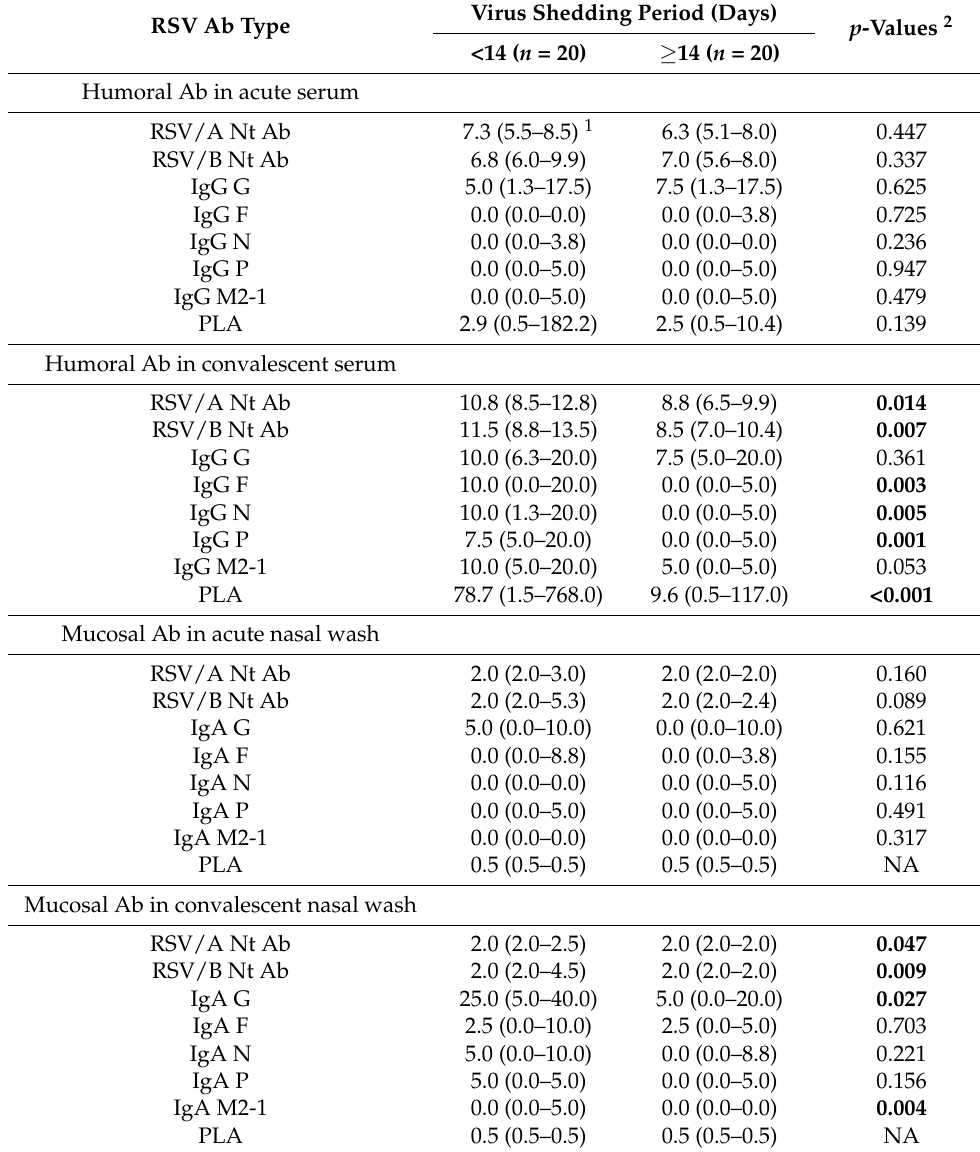
Table 2. Comparison of Humoral and Mucosal RSV Antibody Level between RSV-Infected HCT Recipients Who Shed RSV < or ≥ 14